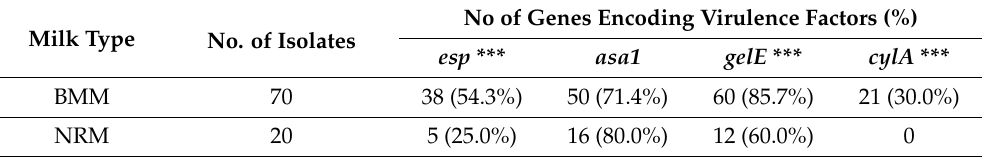
Table 1. Distribution of virulence genes among Enterococcus faecalis isolates from bovine mastitis milk (BMM) and bovine normal raw milk (NRM).